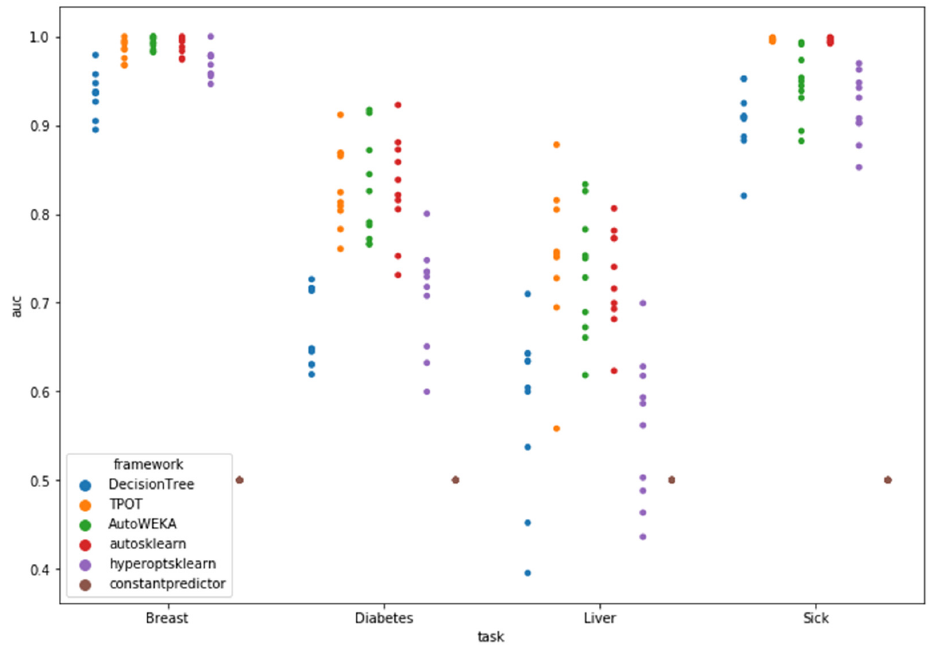
Figure 3. One hour benchmark test results.